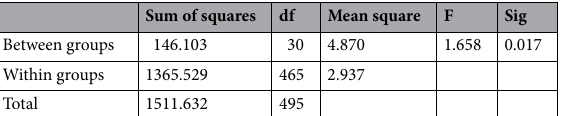
Sum of squares df